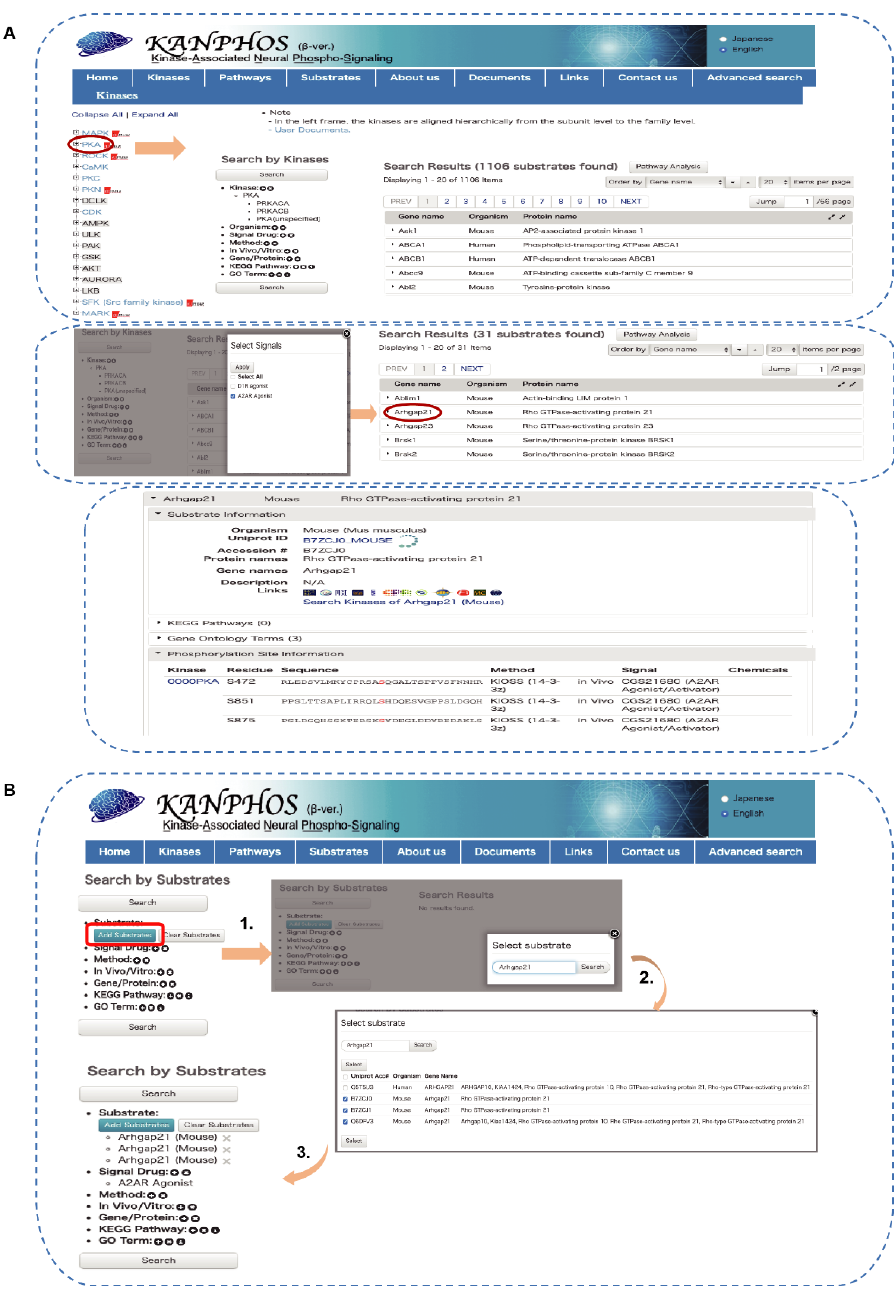
Figure 6. Workflow of KANPHOS for the identification of adenosine-A2A receptor-mediated signaling molecules. ( A ) Identification of Arhgap21 as a PKA candidate substrate downstream of adenosine signaling using “Kinases” search. Red circle represents the selected option and arrow indicates result outcome after each selection; ( B ) Identification of kinases which may phosphorylate Arhgap21 downstream of adenosine signaling using “Substrates” search. Red rectangle represents the selected search option and arrow indicates result outcome after each selection.